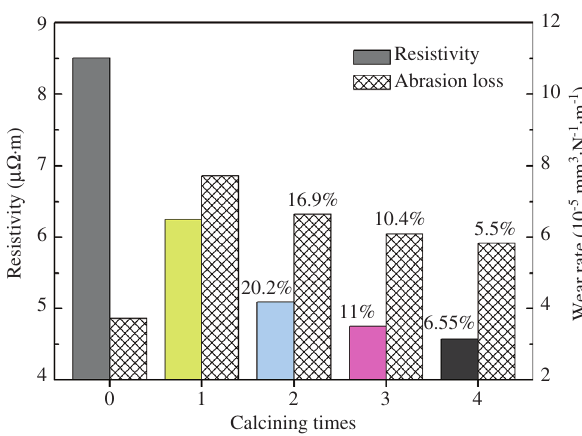
Figure 8 Resistivity and wear rate with the time of